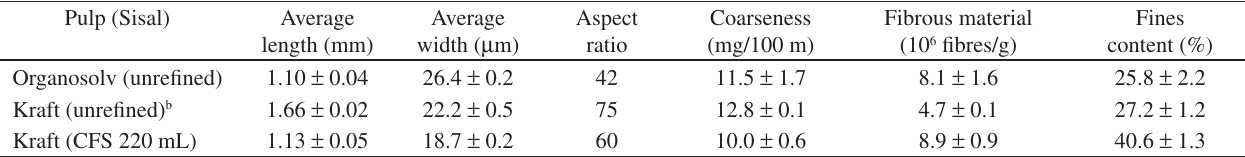
Table 4. Sisal pulp and fibre physical properties a